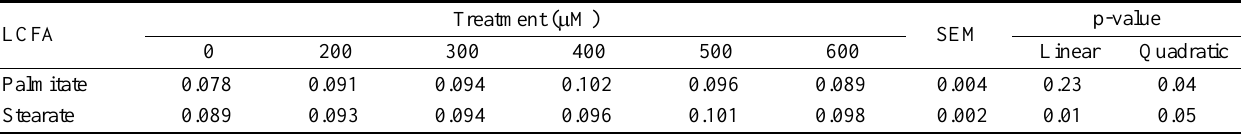
Table 3. Effect of palmitate and stearate on TAG contents in BMECs